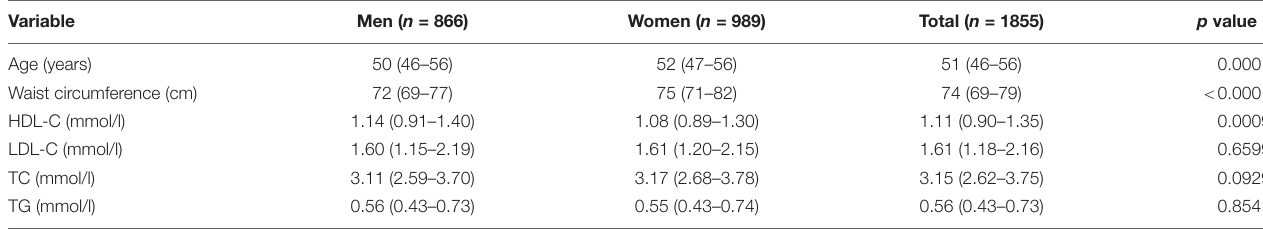
TABLE 2 | Basic characteristics of the study population in northern Ghana.